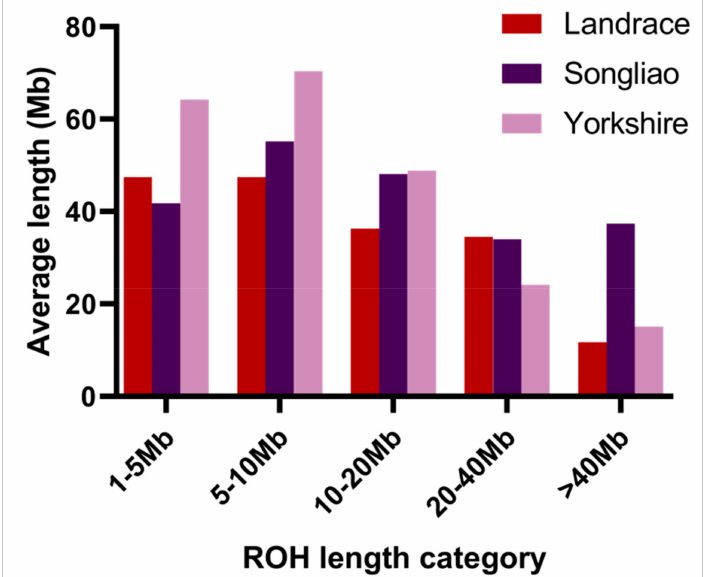
Figure 2. Classification of runs of homozygosity (ROH) in five di ff erent length categories (from 1–5 Mb to more than 40 Mb ) (x-axis) and average length of runs of homozygosity (ROH) in five di ff erent length categories